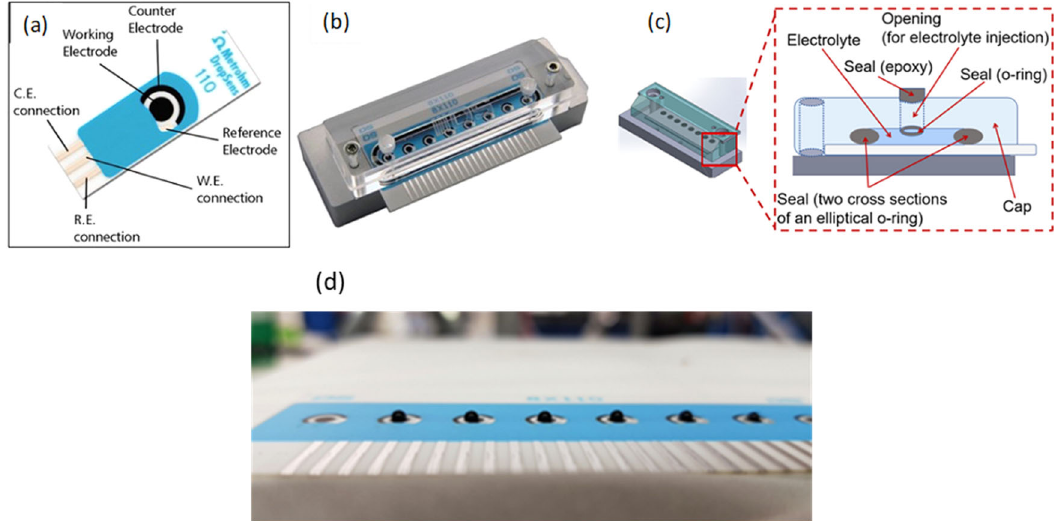
Fig. 3 Screen-printed electrodes and DropSens Channel-Flow Cell. a Picture of screen-printed carbon electrodes (SPE), b Metrohm DropSens Channel Flow-Cell for eight format screen-printed electrodes with reference and counter electrodes used in the AELISS electrochemical system, c simpli fi ed schematic of the transversal view of a fl ow-channel to illustrate how the liquid electrolyte will be introduced in the fl ow channels and how this electrolyte will be contained, and d picture of SPE with a 2- μ L drop of Pt nanocubes on Carbon Vulcan XC-72R ink.